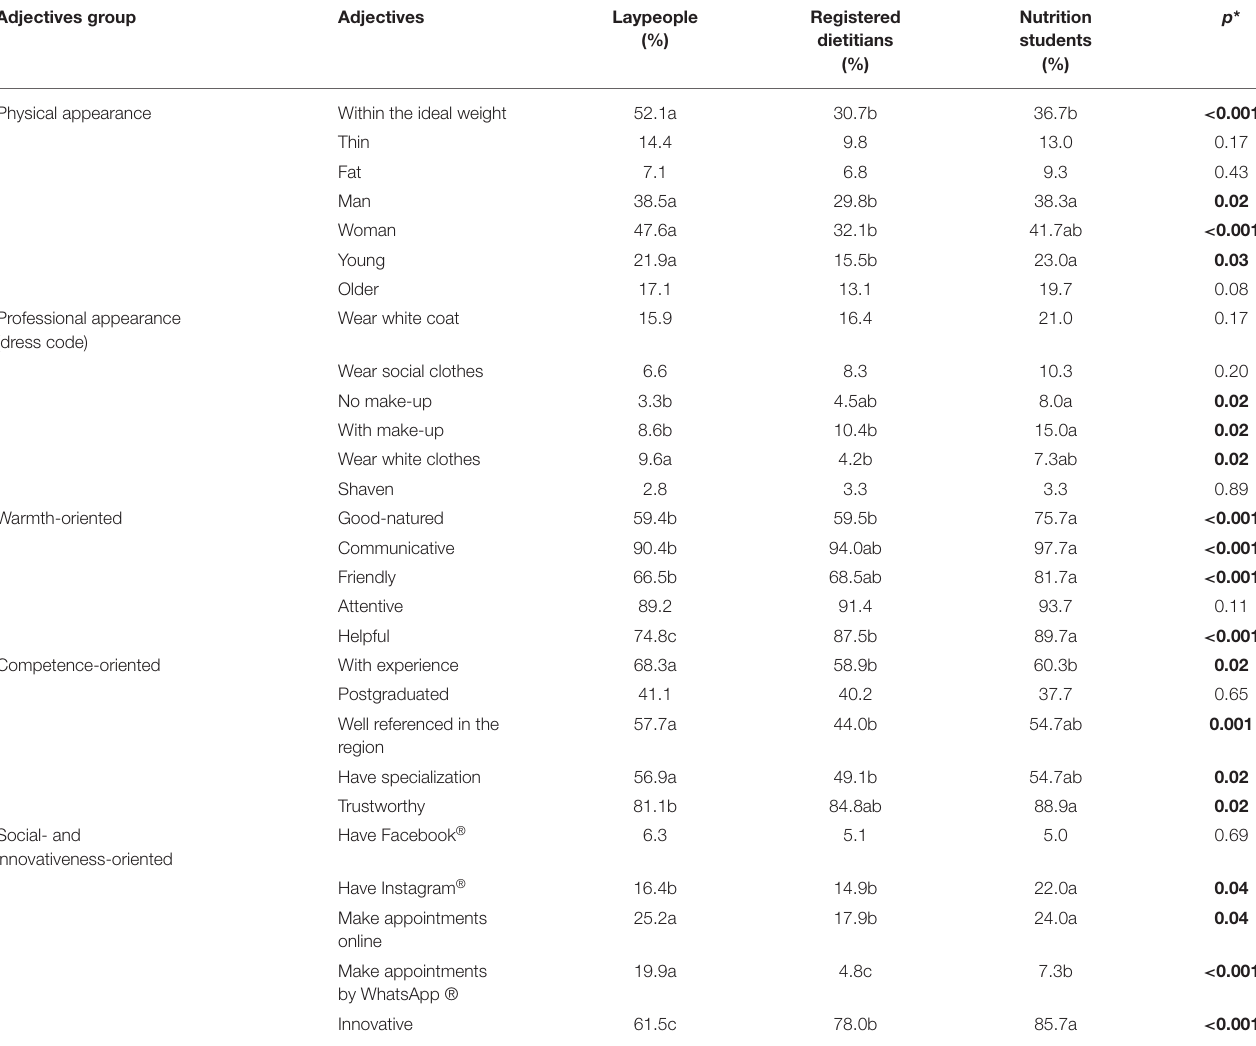
TABLE 5 | Adjectives attributed to a good dietitian according to laypeople, registered dietitians, and nutrition